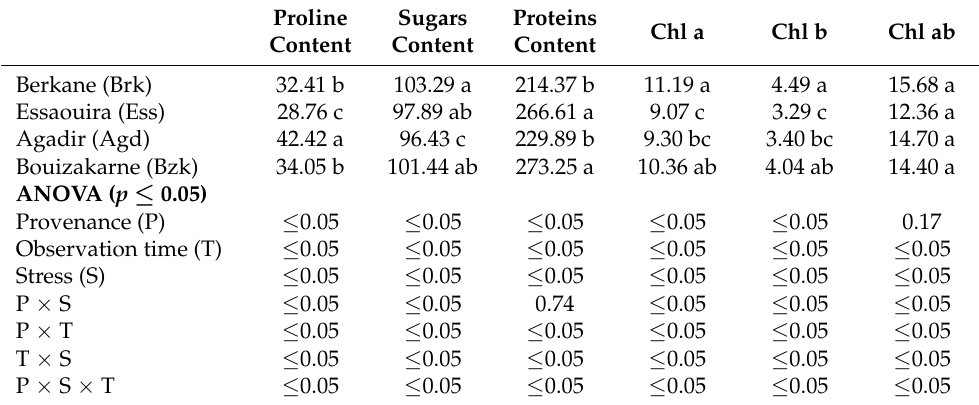
Table 2. Analysis of variance (ANOVA) showing the effect of provenance, observation time, and drought stress and their interaction (ANOVA) on the biochemical parameters studied in the four contrasting provenances of the A. spinosa (Berkane, Essaouira, Agadir, and Bouizakarne). Proline